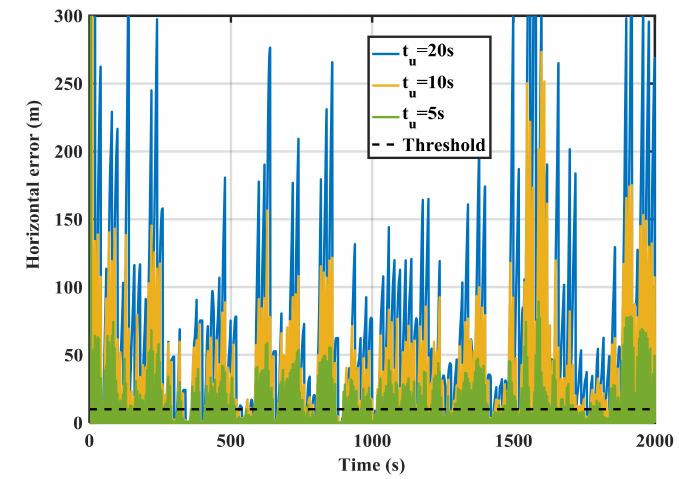
Figure 15. RIO horizontal error for various update intervals ( t u ) in the spoofing case for MEMS IMU.